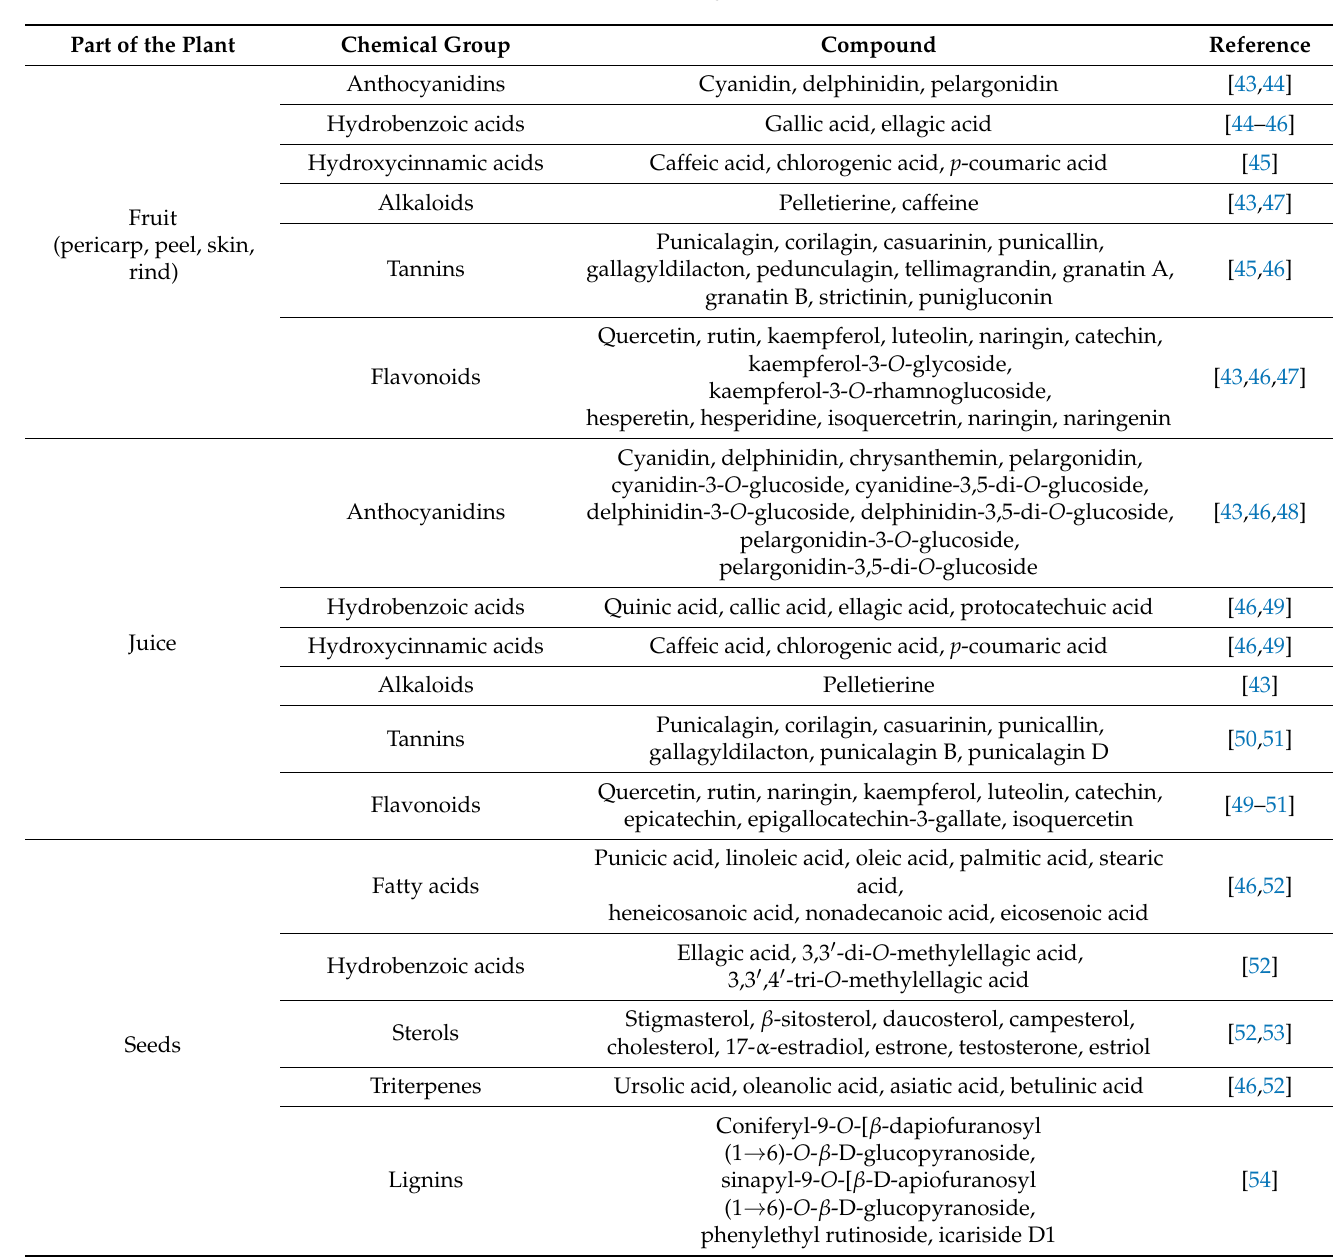
Table 1. Main chemical content of P. granatum